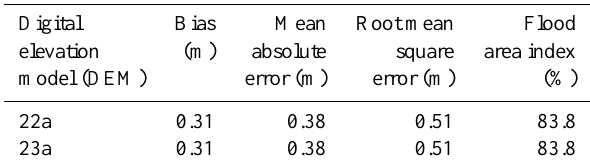
Table 1. Error statistics for two simulation runs of the flood event in 2005. Note: the “flood area index” was only calculated for the southern part of the study area (DEM “22a”: dike heights as in 2005; DEM “23a”: dike heights as in 2005 but artificially opened at two breach locations at the municipality of Pflach as described by Kröll,